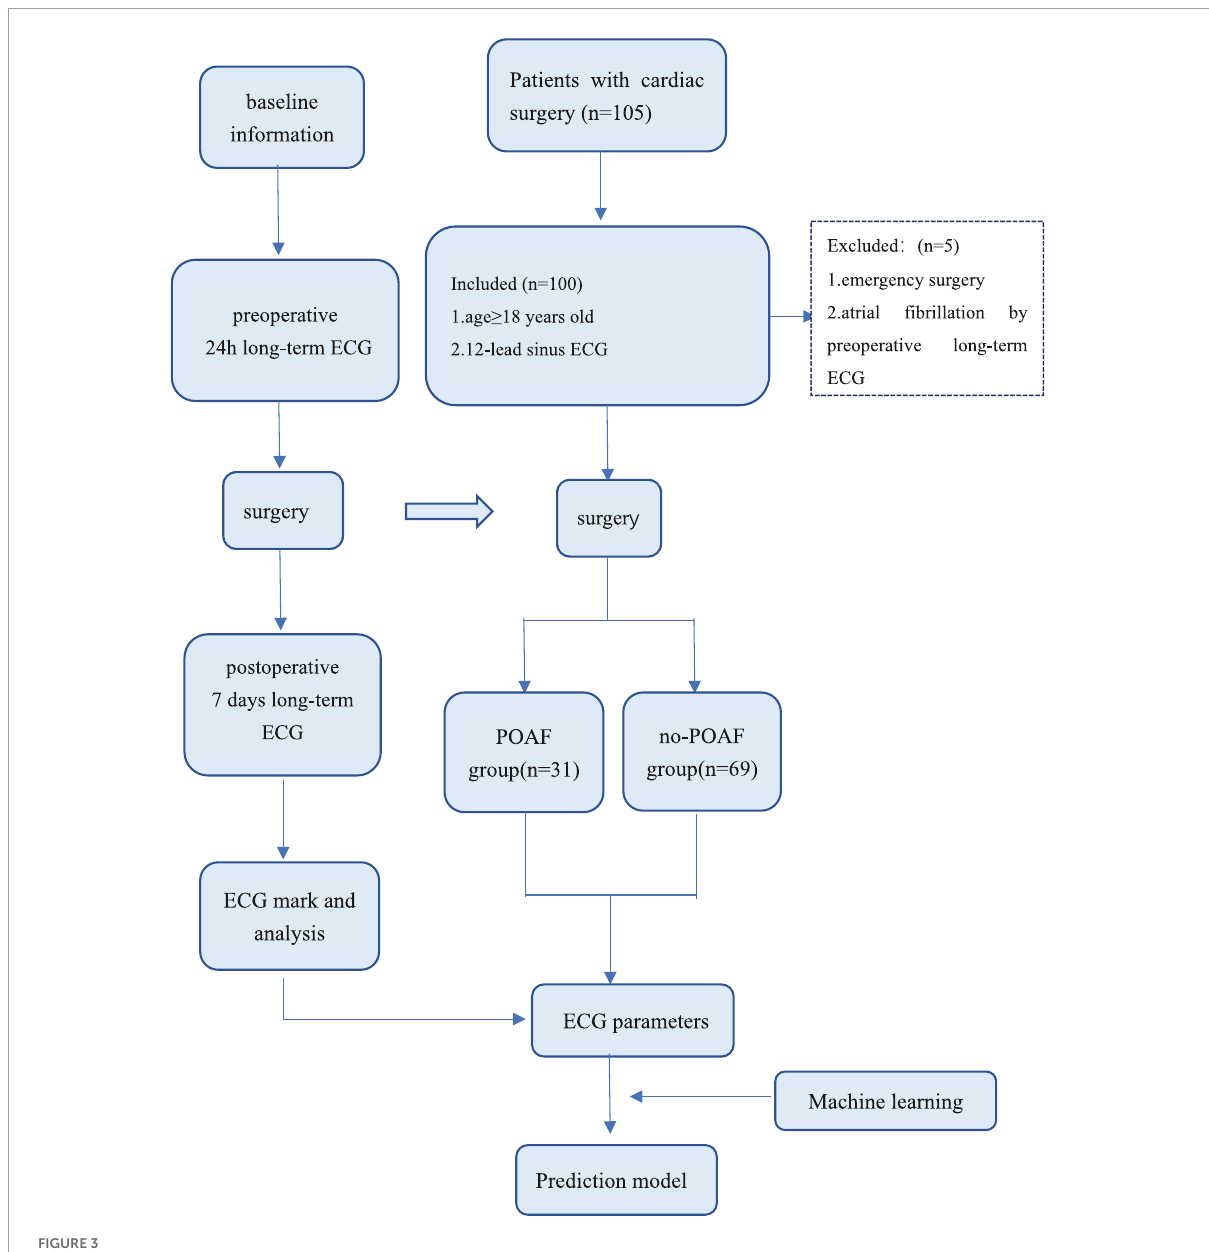
FIGURE3 Study flowchart. ECG, electrocardiogram; POAF, postoperative atrial fibrillation.